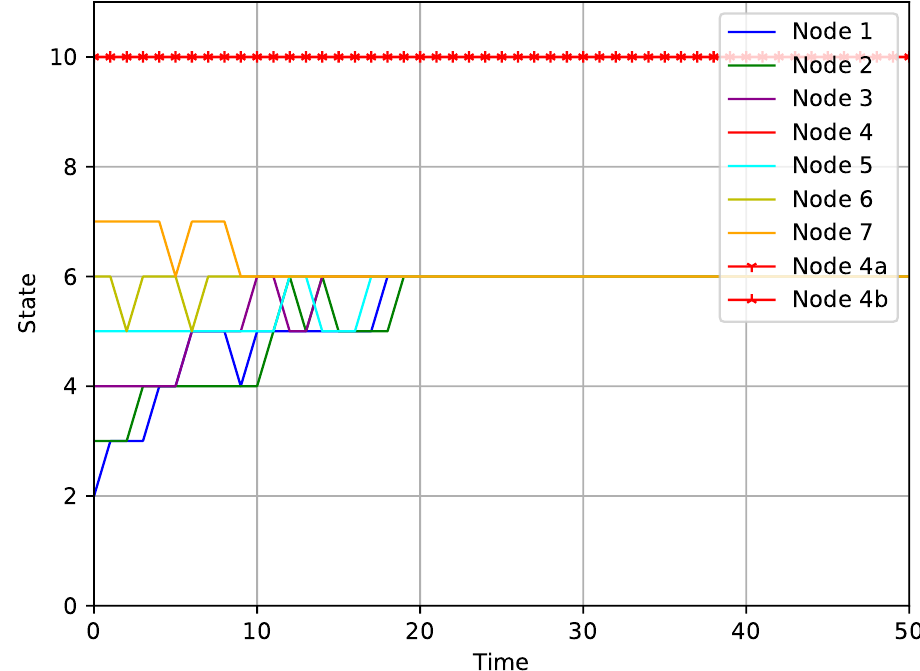
Figure 9. Simulation results of our proposed algorithm under 3-robust